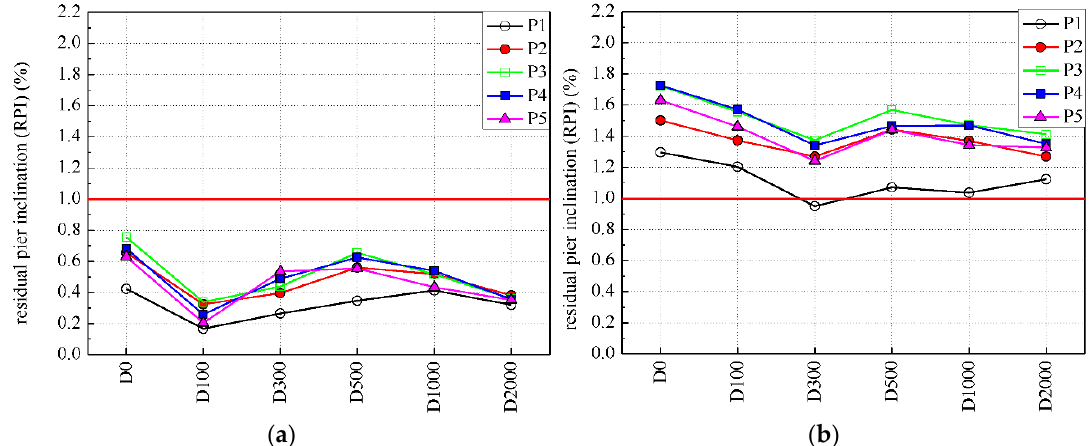
Figure 15. Residual pier inclination. ( a ) Stopper = 4 cm. ( b ) Stopper = 8 cm.